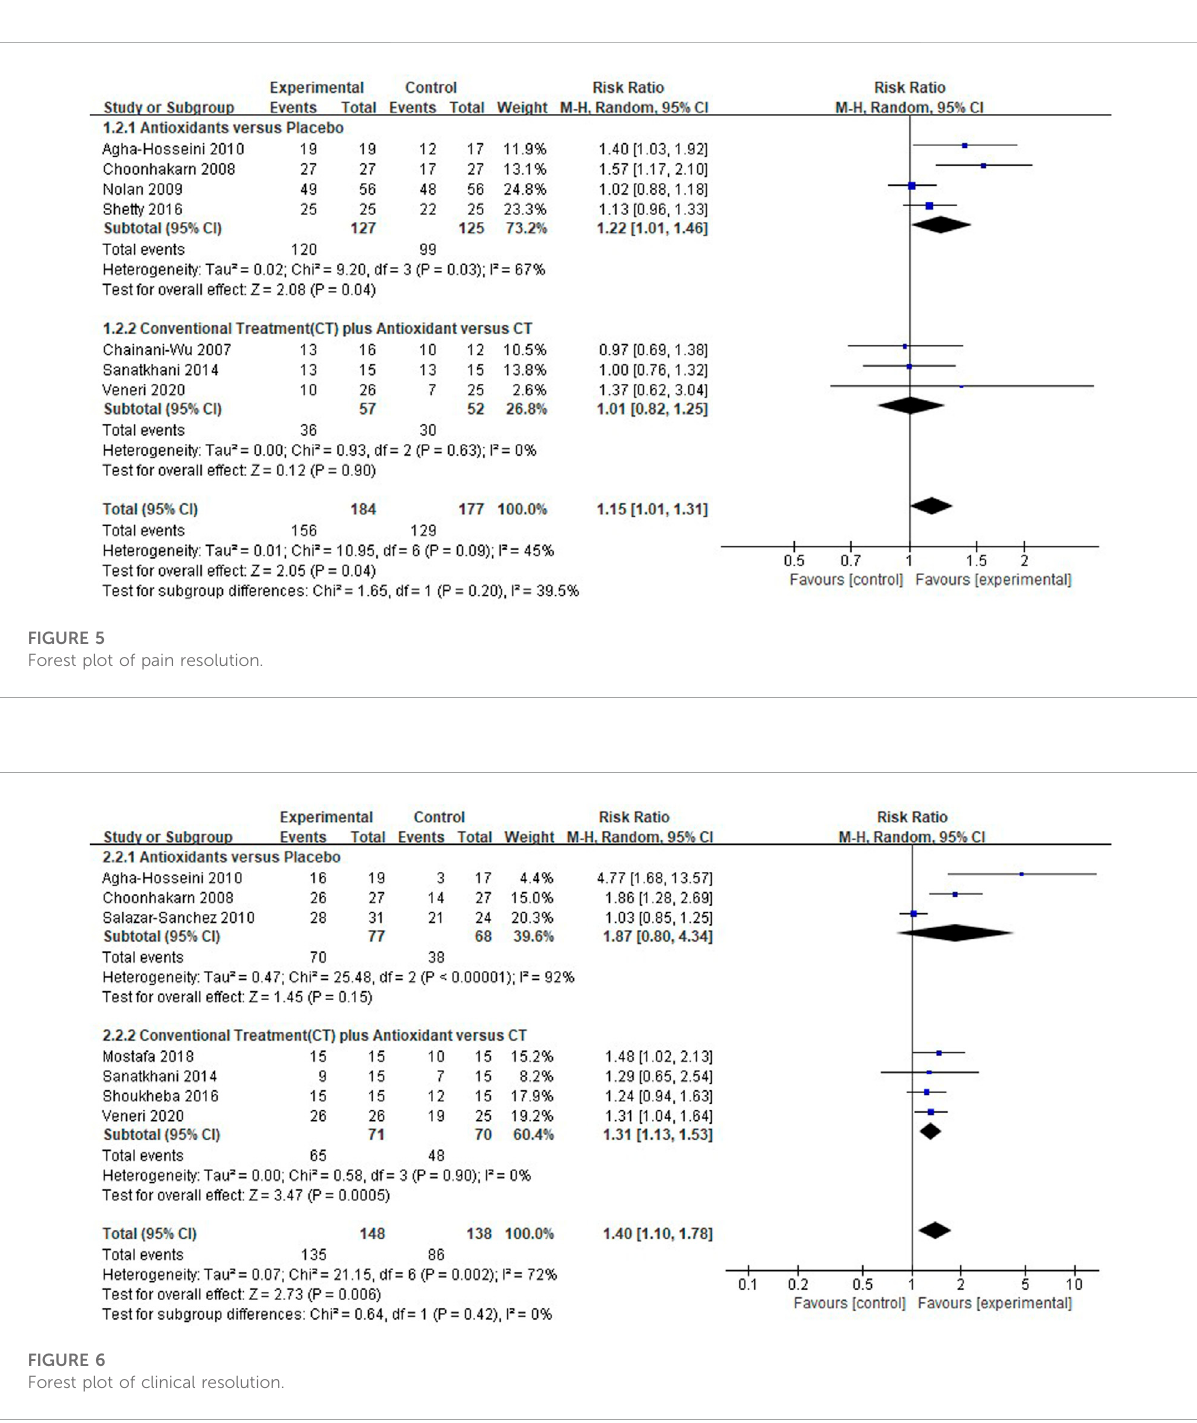
FIGURE 6 Forest plot of clinical